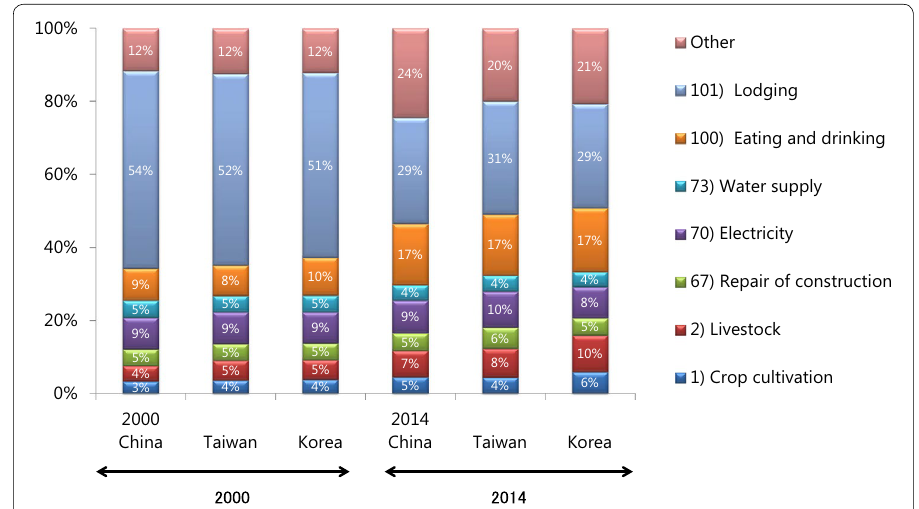
Fig. 3 Repercussion effects of visitor’s consumption on waste generation by